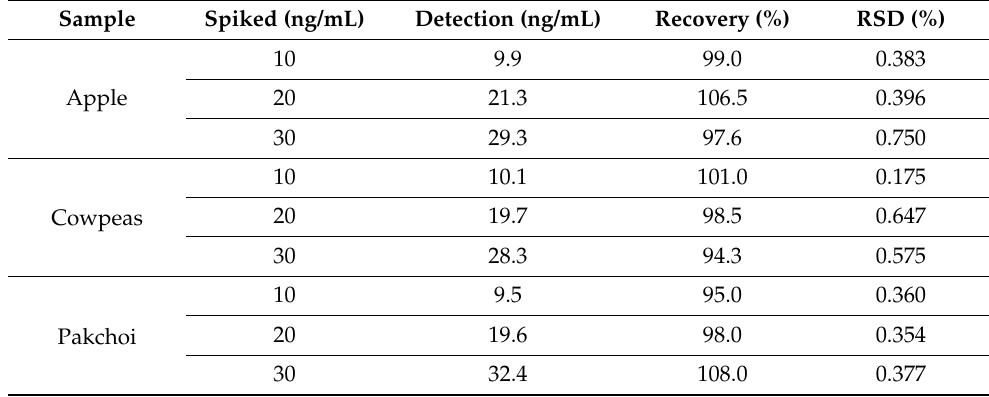
Table 3. Recovery test results of OPs in different samples using our assay. Sample